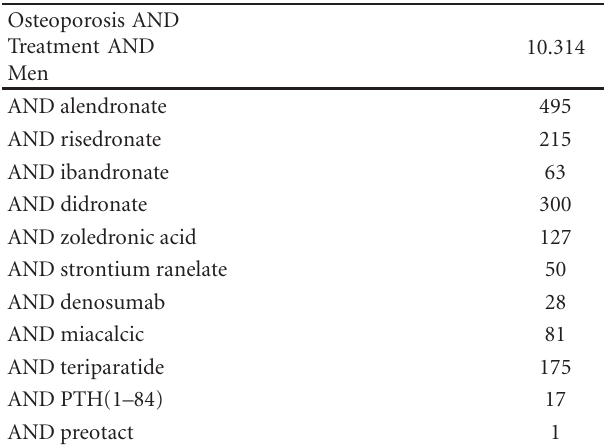
Table 1: Identifying key